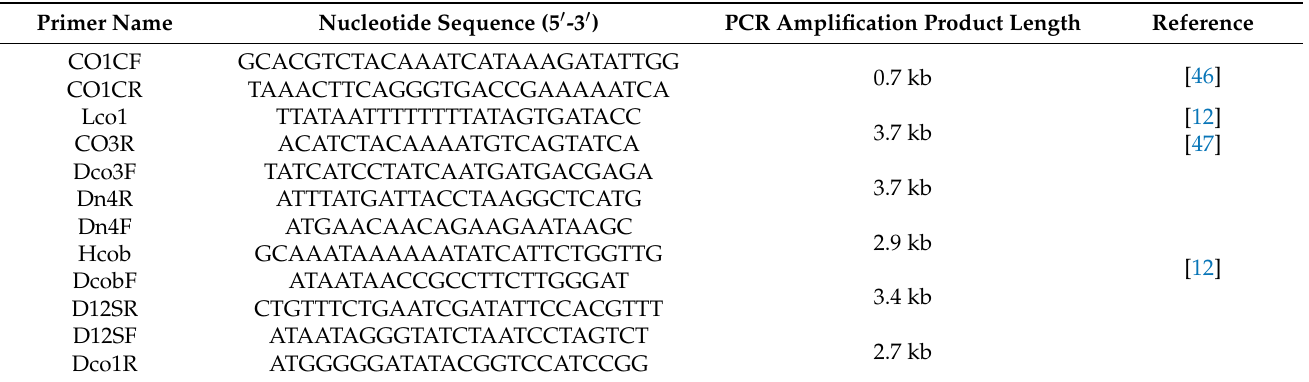
Table 1. PCR primers used in this